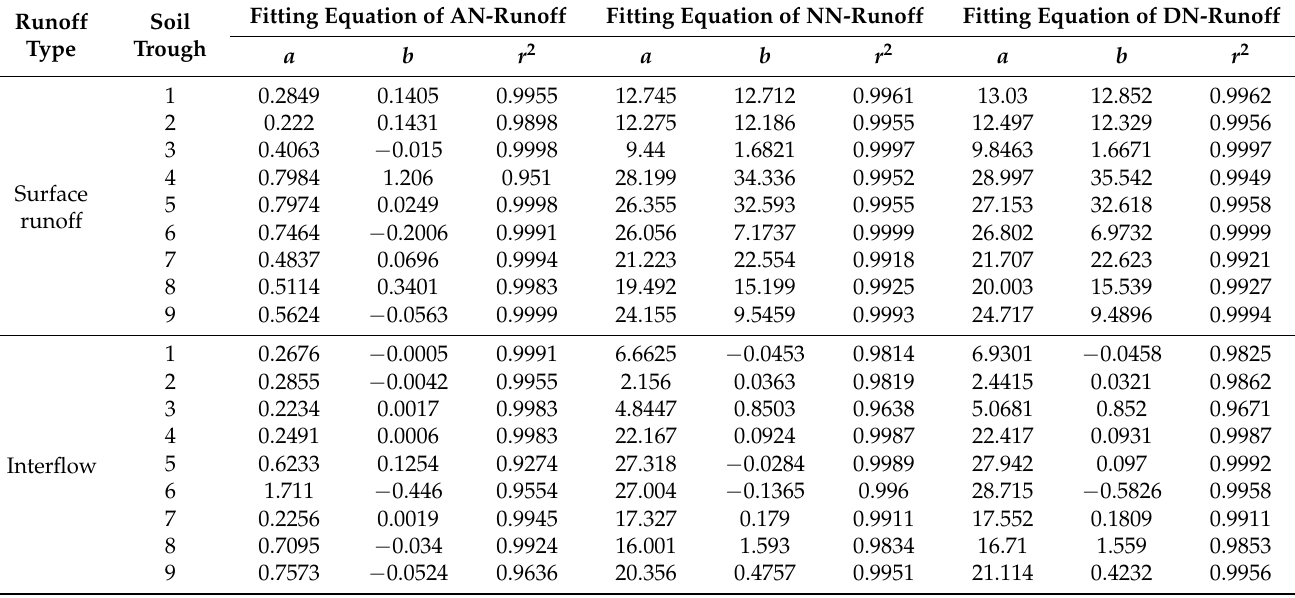
Table 6. Fitting equations * of ammonia nitrogen (AN), nitrate nitrogen (NN) and dissolved nitrogen (DN) loss ( y ) and runoff ( x ) in surface runoff and